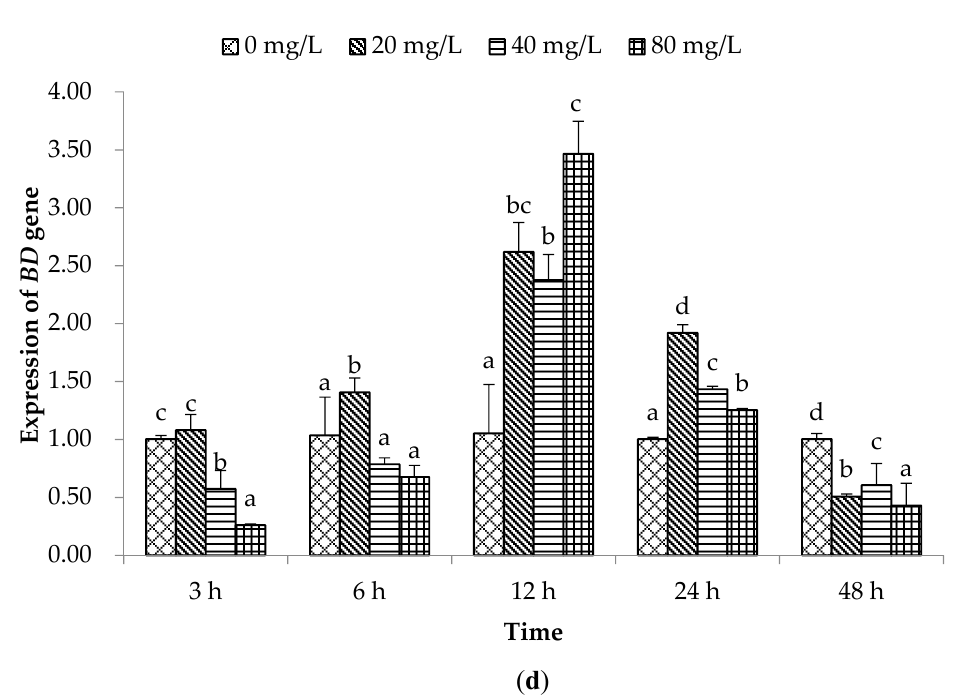
Figure 2. Effects of PA on immune related genes in bay scallop A. irradians at different time points after exposure to three concentrations (20, 40, and 80 mg/L). ( a ) PrxV gene; ( b ) CLT-6 gene; ( c ) MT gene; ( d ) BD gene; Data represent mean ± SD values ( n = 3 ) at the same sampling time with different letters denoting significant differences ( p < 0.05).